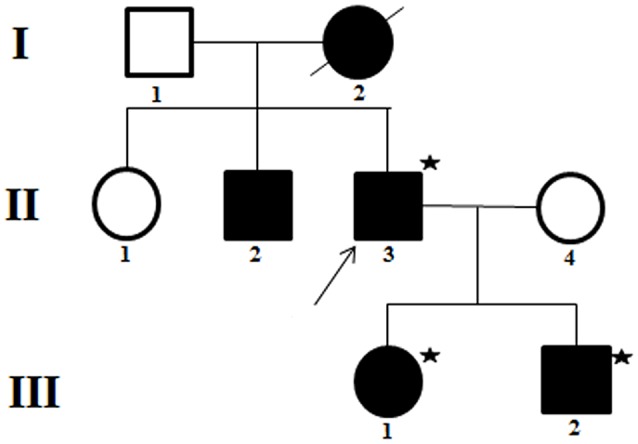
Pedigree of a family presenting with normokalemic periodic paralysis (NormoKPP). The filled symbols indicate individuals with NormoKPP, whereas the open symbols show individual without NormoKPP. The individuals with asterisks were examined by gene sequencing. The arrow indicates the index case.